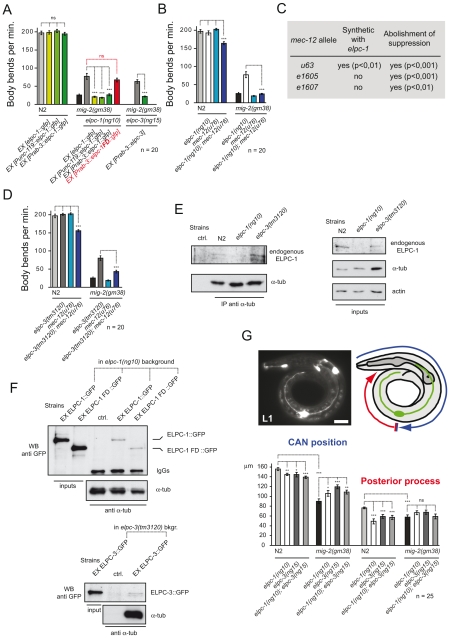
The elongator interacts genetically and physically with mec-12/α-tubulin and is required for correct neuronal morphology.(A) Rescue experiment of elongator mutants in different genetic backgrounds measuring body bends per minute. The elongator is required in neurons since the suppression of mig-2(gm38) is rescued by expressing elongator using neuron specific unc-119 and rab-3 promoters. Truncated Familial Dysautonomia version of ELPC-1 (elpc-1FD) does not rescue. (B) Body bends per minute of different genetic backgrounds showing synthetic defect of mec-12(u76); elpc-1(ng10) double mutants and the requirement of wt mec-12/α-tubulin for suppression of mig-2(gm38) by elpc-1(ng10). (C) Table of genetic interactions between elpc-1(ng10) and different mec-12 alleles. Synthetic effects on movement of different mec-12 alleles in a double mutant background with elpc-1(ng10): all mec-12 alleles abolish the suppression of unc phenotype in mig-2(gm38); elpc-1(ng10) worms. (D) Body bends per minute showing synthetic defect of mec-12(u76); elpc-3(tm3120) double mutants and the requirement of wt mec-12/α-tubulin for suppression of mig-2(gm38) by elpc-3(tm3120). (E) CoIP of endogenous ELPC-1 with endogenous α-tubulin in different mutant backgrounds. α-tubulin was immunoprecipitated from protein lysates and immunoblotted with an anti-ELPC-1 antibody to detect co-precipitating ELPC-1 (left upper panel). The lower left panel shows the total amount of immunoprecipitated α-tubulin. Inputs (1/50 of total lysate) of ELPC-1, α-tubulin and actin (loading control) are shown on the upper right panels. (F) CoIP of full length or truncated (FD) ELPC-1::GFP with endogenous α-tubulin in elpc-1(ng10) mutants and wt strains (as a control). α-tubulin was immunoprecipitated and immunoblotted with an anti-GFP antibody to detect co-precipitating GFP tagged proteins (FD)::GFP (upper panels). Inputs (1/50 of total lysate) are shown on the left side of the panel. The blot was re-probed with anti-α-tubulin antibody to detect the total amount of immunoprecipitated protein (upper panels; IgGs: heavy chains). The lower panels show the CoIP of ELPC-3::GFP in elpc-3(tm3120) mutants with α-tubulin (Input: 1/50 of total lysate). (G) CAN cell position and posterior process extension measured in L1 larvae of different genetic backgrounds. Upper panels: left: fluorescence micrograph showing expression of ceh-10::gfp marker for the CAN neuron. Bar 10 µm; right panel: scheme explaining how measurements were performed; lower graph: average position of CAN neuron or posterior process extension. P values: ns = not significant; *<0,05; **<0,01; ***<0,001. Error bars: SEM.